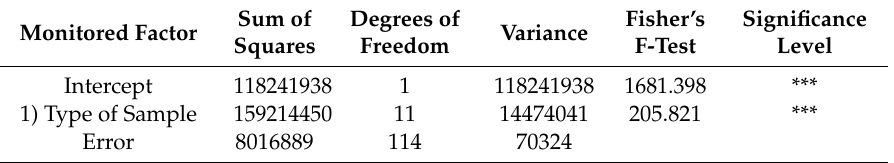
Table 18. Statistical evaluation of the e ff ect of the factors and their interaction on the minimum bend radius at the yield point ( R minB ) for beech and NWC on top.